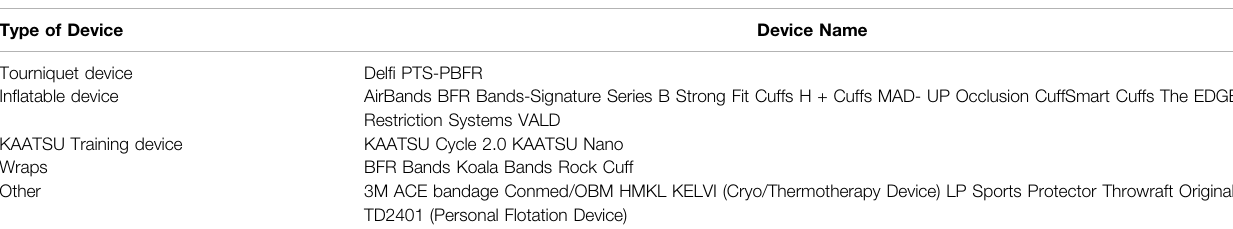
TABLE 7 | Actual device